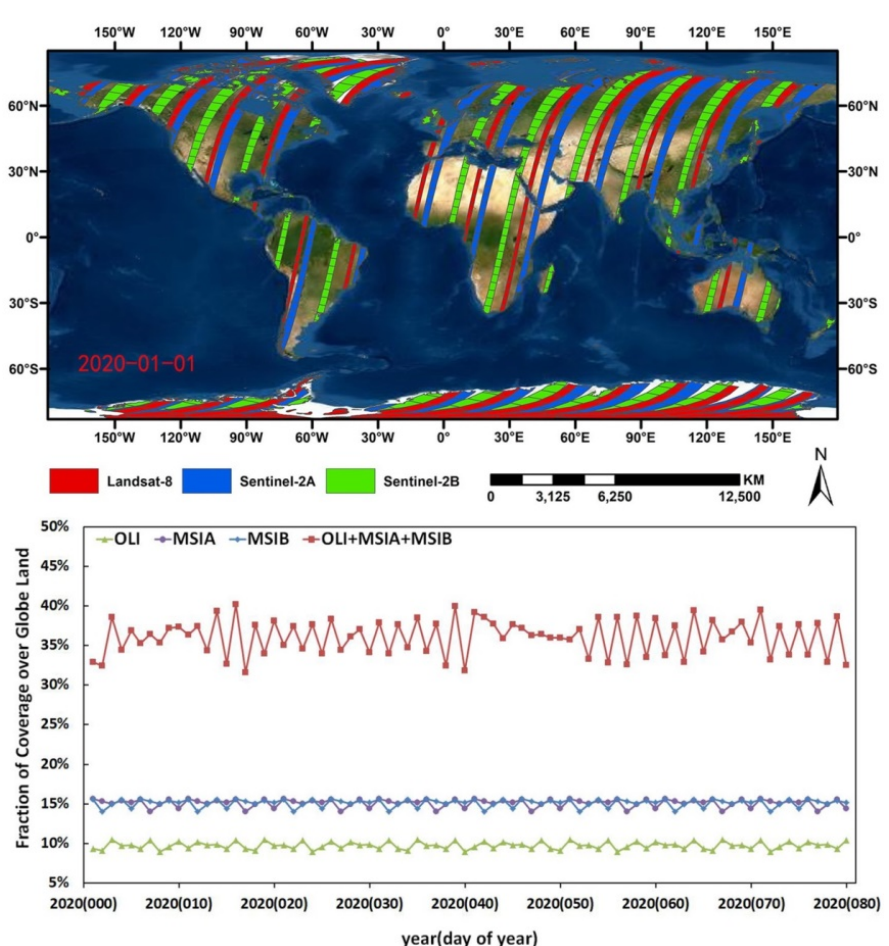
Figure 10. Percentage of potential swath coverage over globe land for Landsat-8, Sentinel-2A, Sentinel-2B and their configurations.